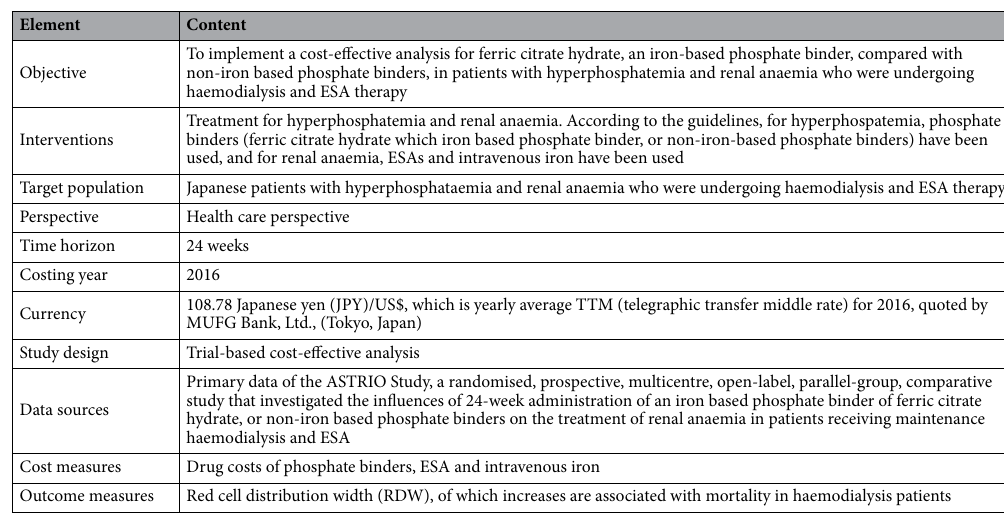
Table 6. Study design and scope of the cost-effectiveness